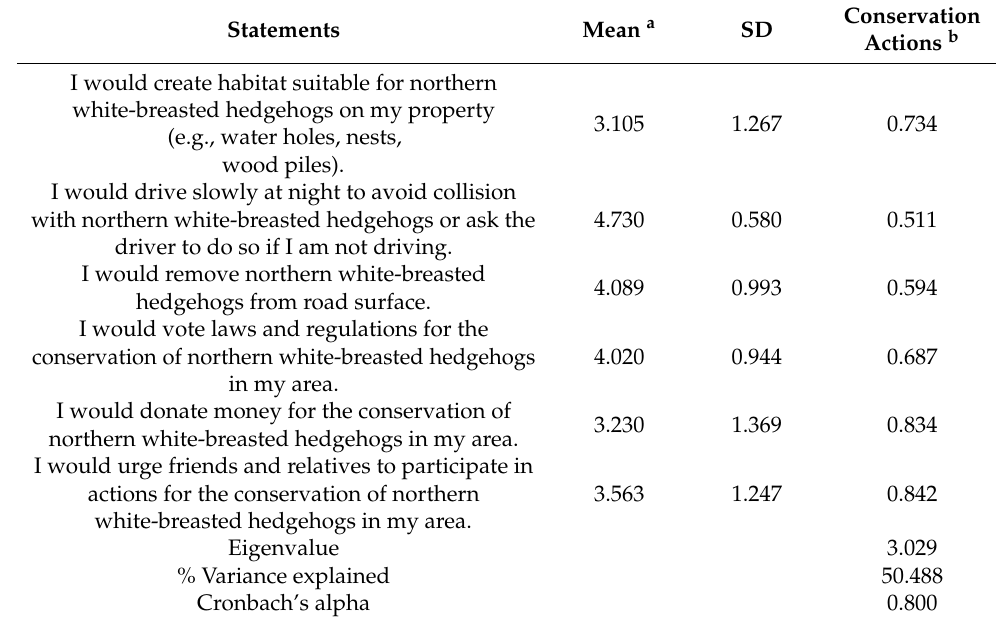
Table 4. Principal components factor analysis of the intention to participate in actions for the conservation of northern white-breasted hedgehogs ( n = 704). Descriptive statistics, factor loadings, factor eigenvalues, % variance explained, and factor reliability are